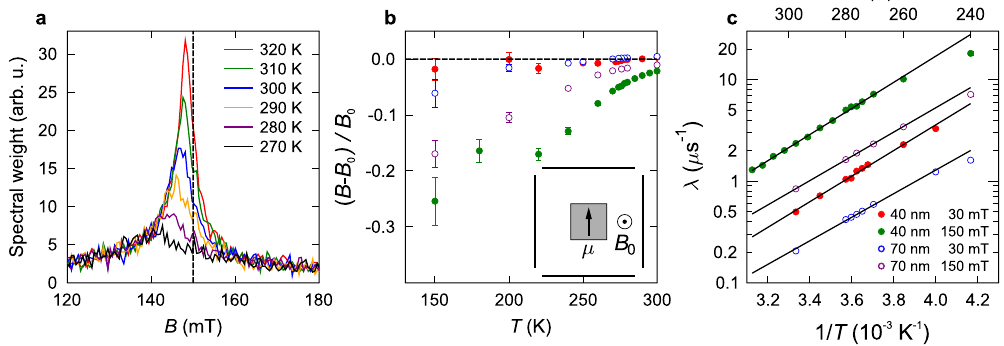
Figure 4. Transverse muon-spin rotation data. ( a ) Fourier spectra measured in an applied field of B 0 = 150 mT for a 40-nm-thick film of FeGe L . Evolution with temperature of ( b ) the diamagnetic shift and ( c ) the relaxation rate λ for the two FeGe films at two values of the applied field B 0 . Temperature-activated behaviour is evident above T = 260 K, as described in the text.